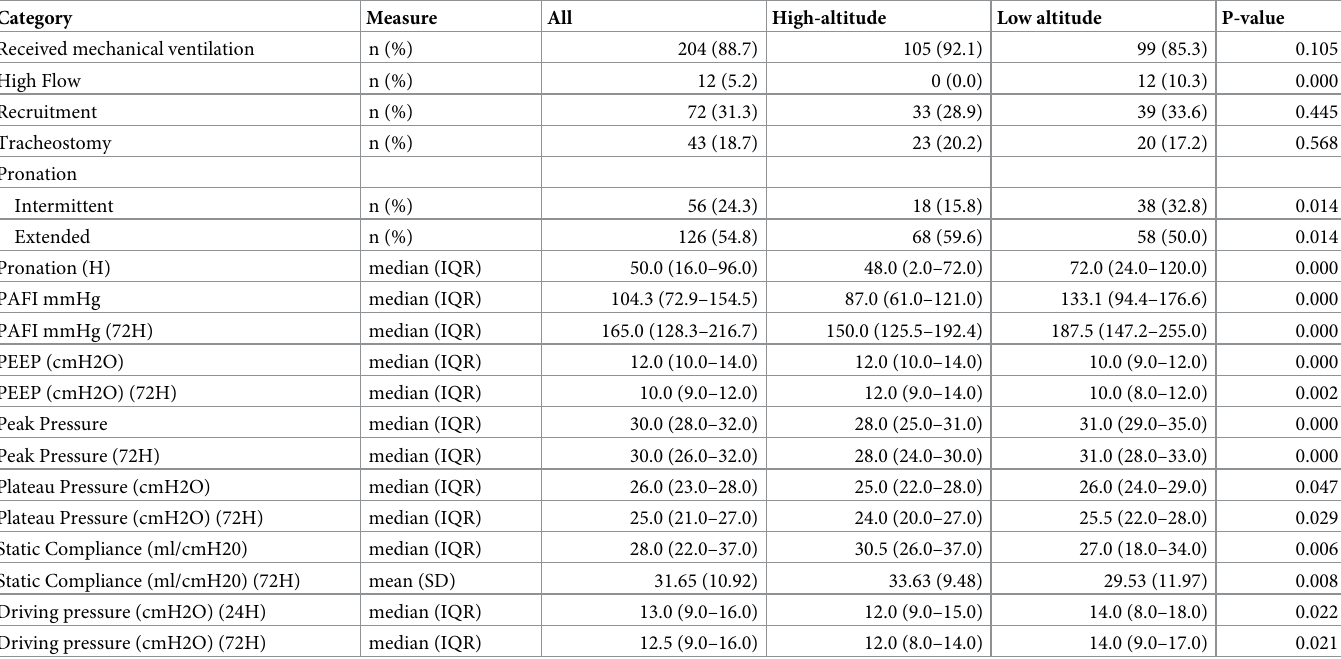
the comparison between groups, the low altitude group received greater numbers of corticoste- roid prescriptions and tocilizumab than the high-altitude group. However, the patients did not show differences in the administration of heparins, antimalarials, or lopinavir/ritonavir (Table 5). Table 4. Ventilatory and pulmonary parameters among COVID-19 patients in the low and high-altitude group. Category Measure All High-altitude Low altitude